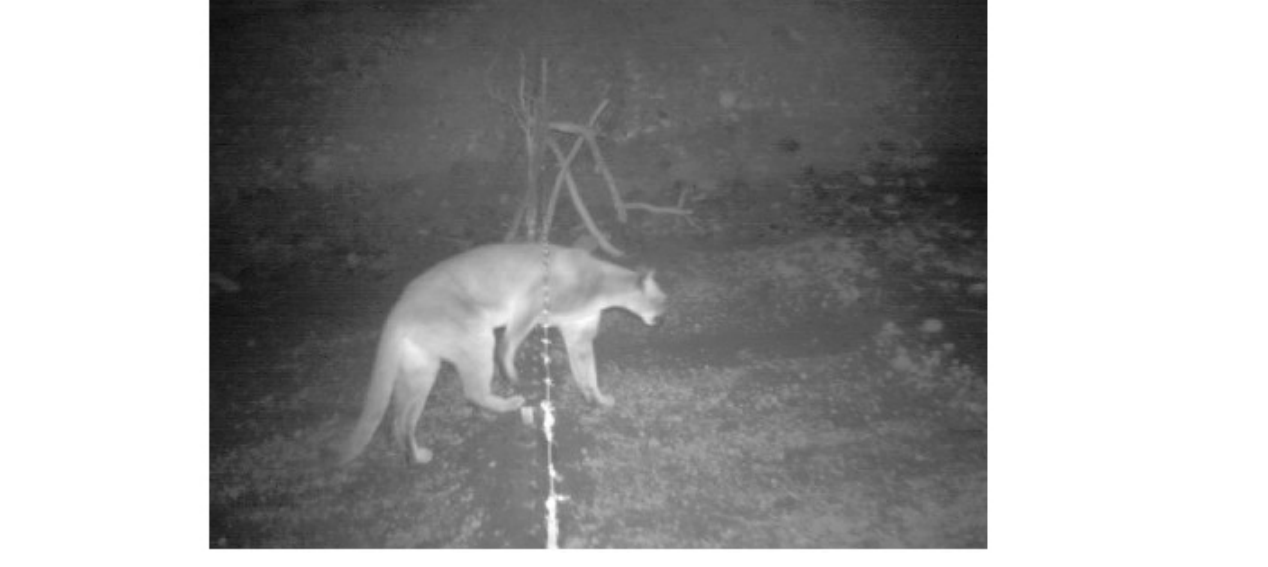
Fig. 4. Cougar passing through hair-sampling system at one of the wildlife underpasses in Banff National